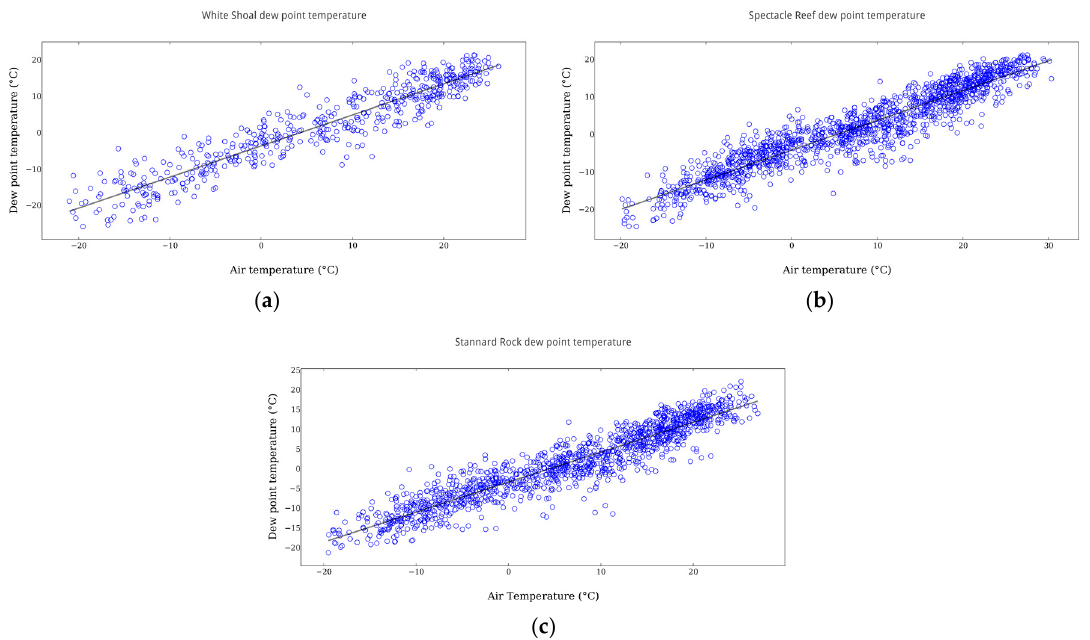
Figure 2 . Scatterplots of hourly mean air temperature derived from MERRA against hourly mean dew point temperature converted from year-round vapor pressure measured from ( a ) WS (25 September 2013–31 December 2014); ( b ) SP (24 September 2009–31 December 31 2014); and ( c ) SR (11 June 2008– 1 April 2012).